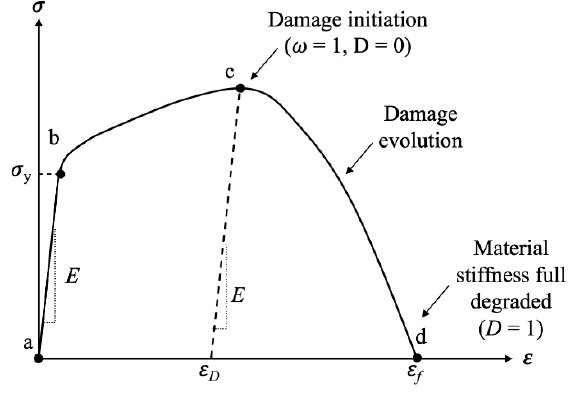
Figure 12. Johnson–Cook stress–strain relationship. Table 3. AA6061-T6 Johnson–Cook material parameters [49].